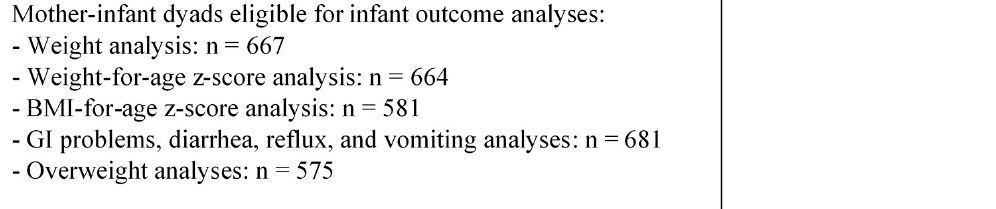
Figure 1. Flow diagram of analytical sample of lactating mother–infant dyads in IFPS II. For analyses of infant outcomes, infants’ LCS exposure via maternal DB intake was estimated by the cross product of maternal DB consumption and breastfeeding intensity. Breastfeeding intensity was operationalized as the percentage of all milk feeds that were human milk, per mothers’ self-report on the postnatal questionnaire. Infants’ LCS exposure via maternal DB intake was then categorized dichotomously as exposed and non-exposed. For supplemental analyses, infants’ LCS exposure via maternal DB intake, accounting for breastfeeding intensity, was further categorized into four mutually exclusive groups (never, ≤ 1 serving/week, <1 serving/day, ≥ 1